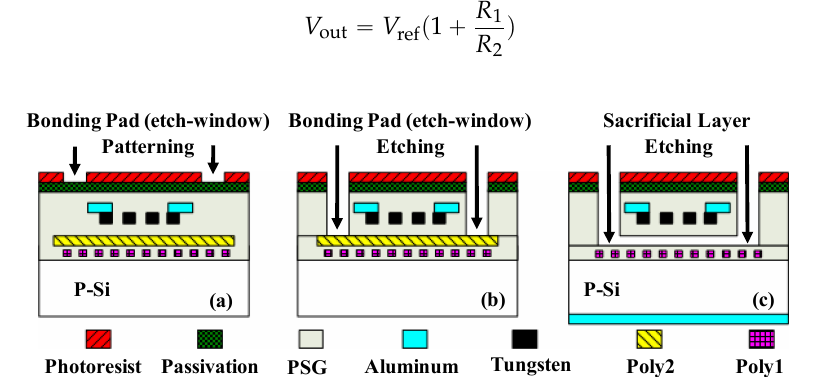
Figure 1. Fabrication of the freestanding structure of the tungsten microhotplate. ( a ) Opening of the etch windows for the tungsten microhotplate; ( b ) Dry-etching process to expose the sacrificial layer for the tungsten microhotplate; ( c ) Suspending of the tungsten microhotplate by the removal of the sacrificial layer.